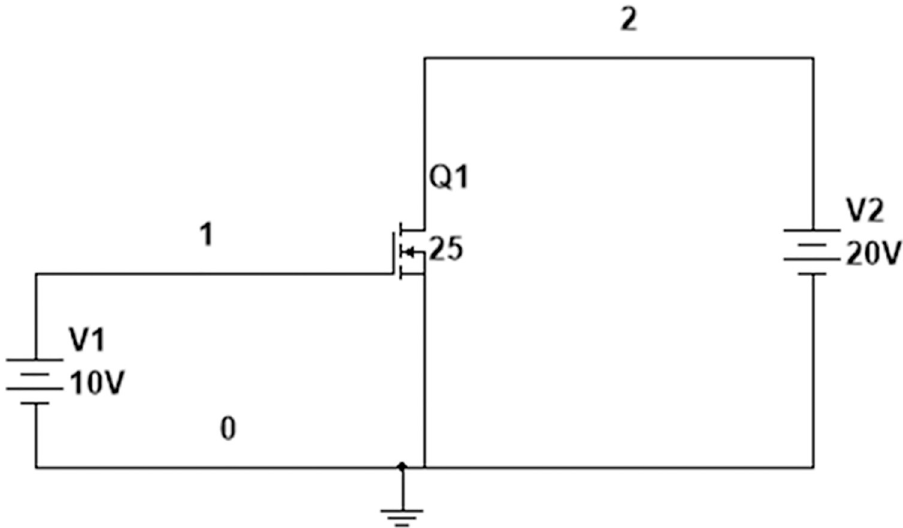
Fig 7. Schematic diagram of input transfer characteristics of sic